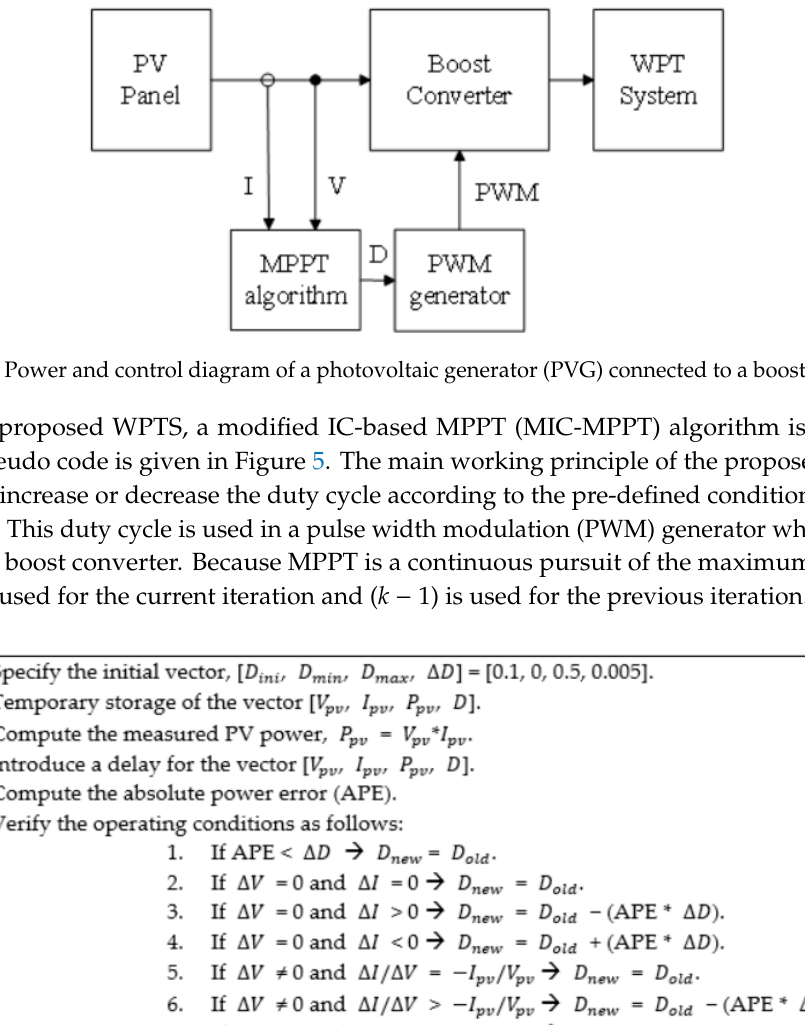
Figure 5. Pseudo code of the implemented maximum power tracking (MPPT) algorithm.